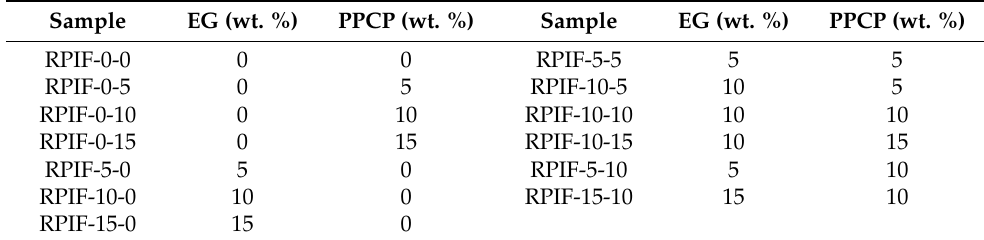
Table 1. Formulation of addition agent of RPIF.